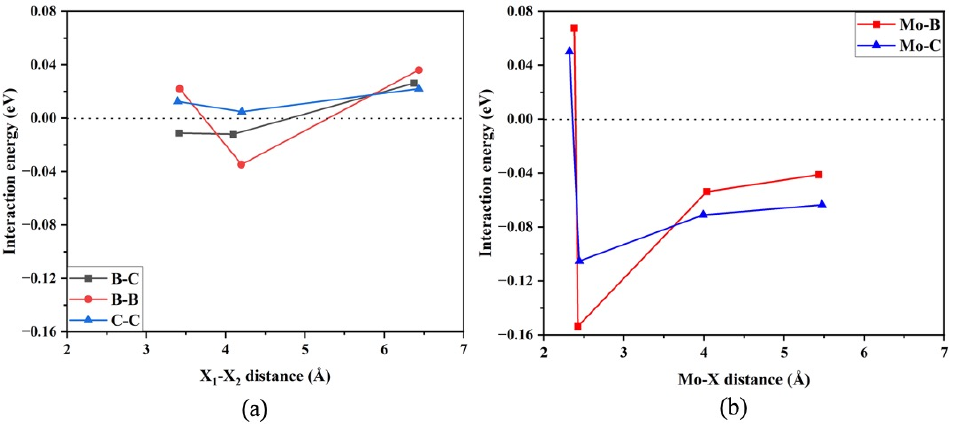
Figure 3. Interaction energy between interstitial solute atoms ( a ) and between Mo and interstitials ( b ).